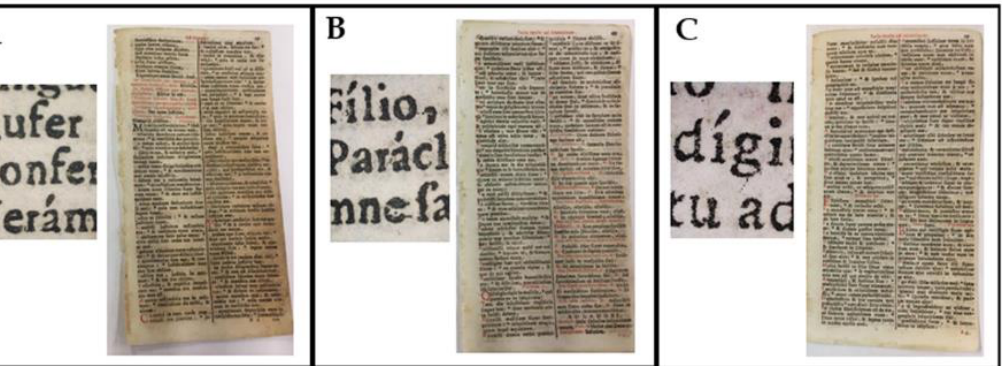
Figure 11. Images of pages and details from Breviarium romanum ad usum fratrum minorum treated with ( A ) water (pristine); ( B ) S_CNC; and ( C ) CNC. Reproduced under terms of the CC-BY